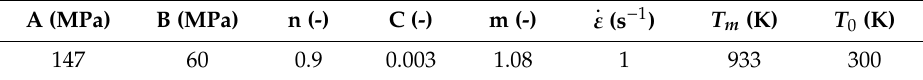
Table 4. Material parameters for the Johnson Cook (JC) model [21].